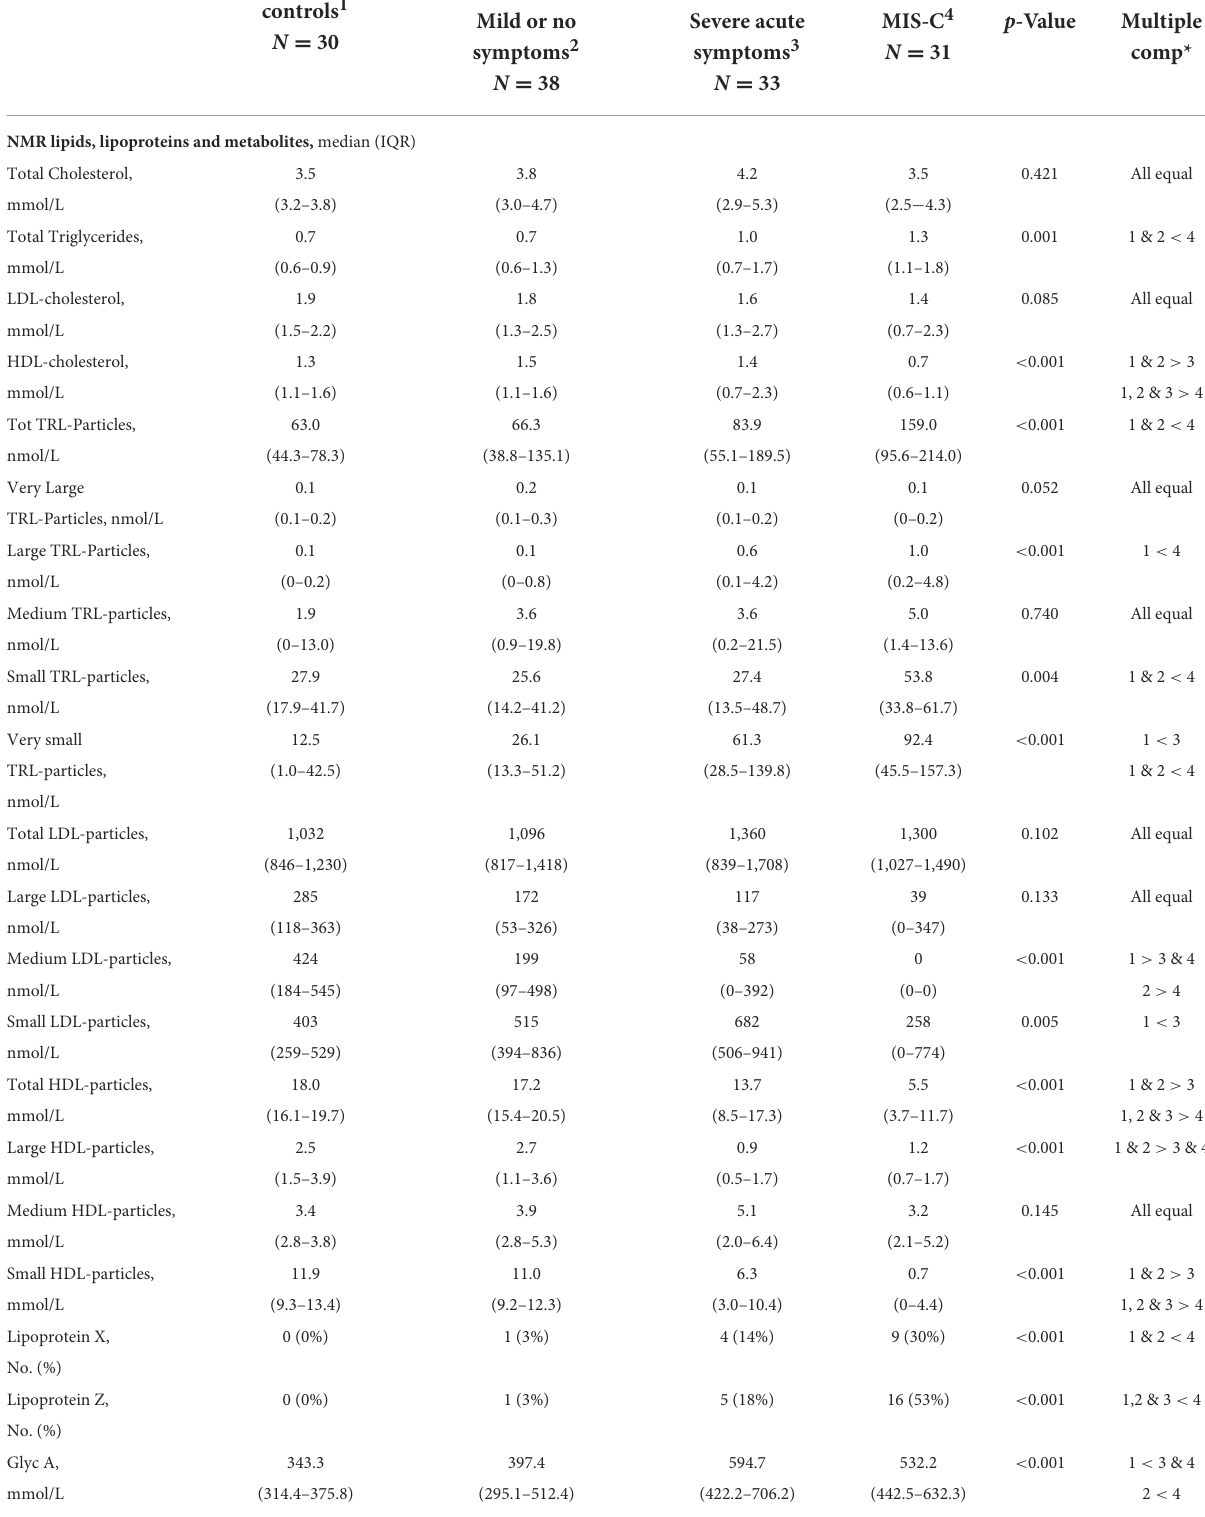
TABLE 3 Lipid profiles, NMR phenotyping and HDL cholesterol efflux